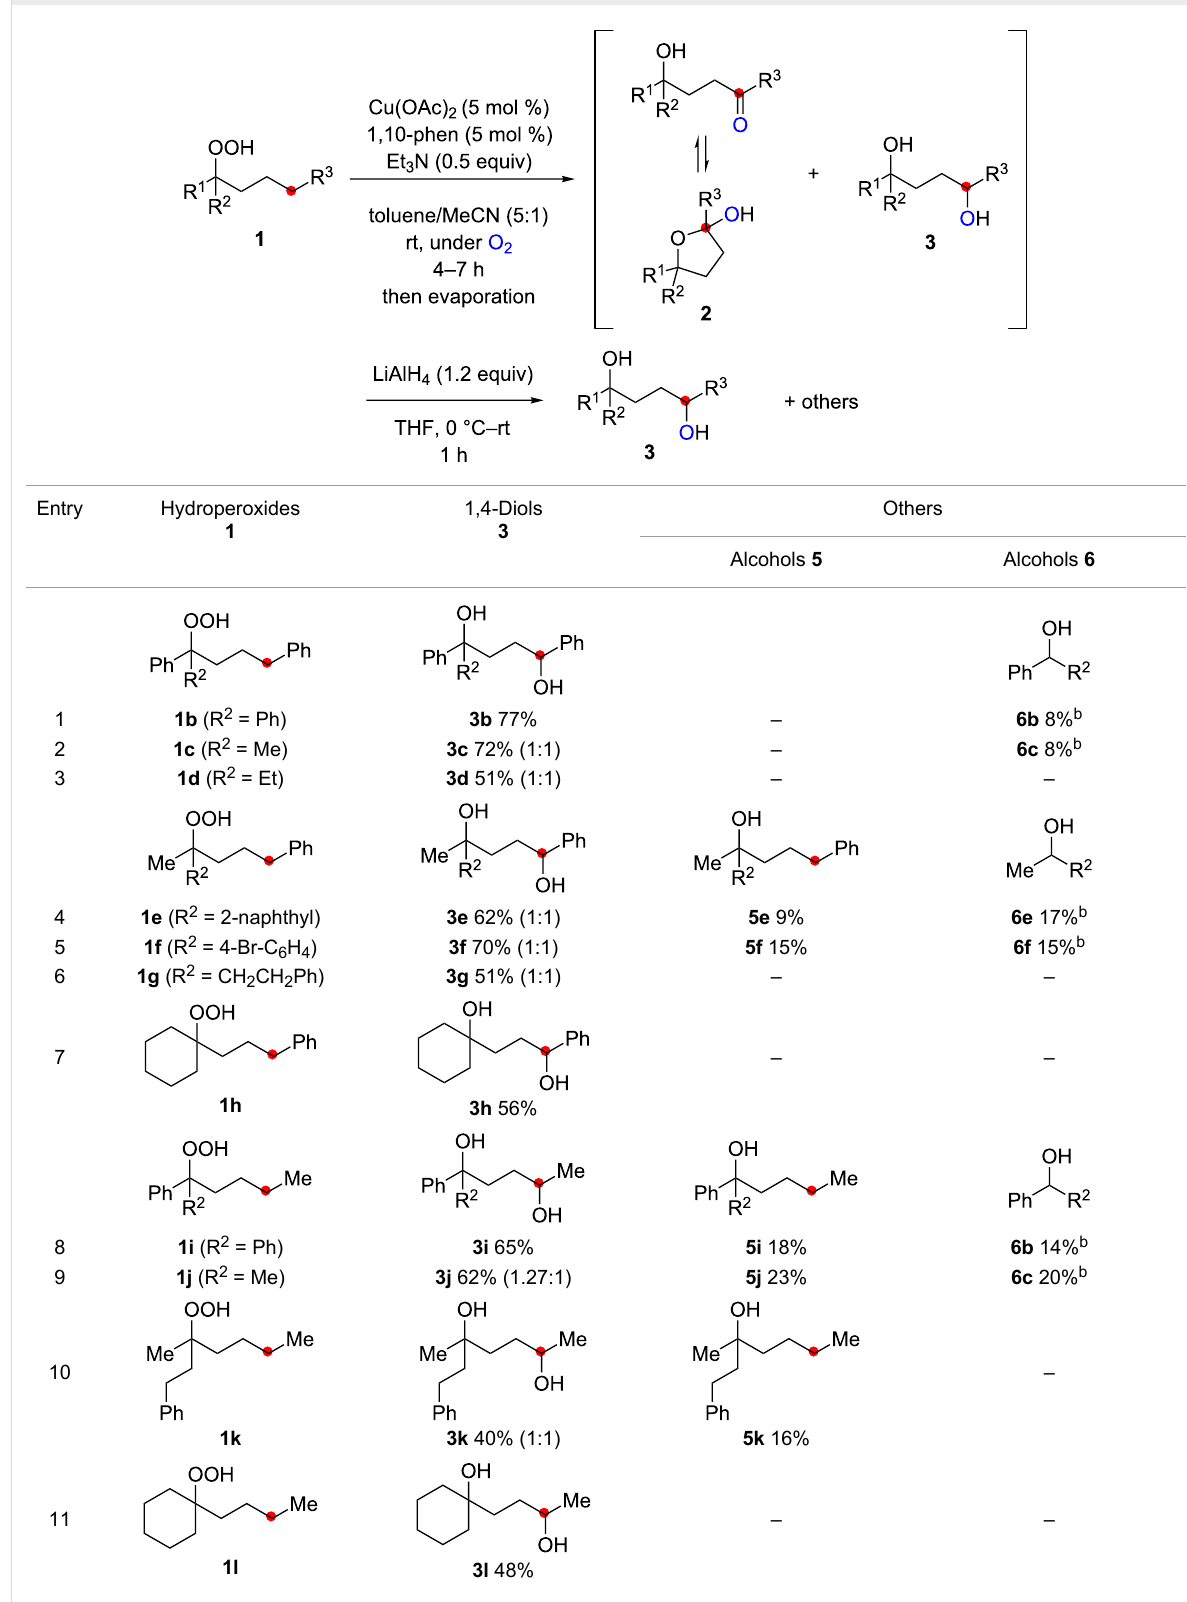
Table 2: Substrate scope: oxygenation of secondary C–H bonds.